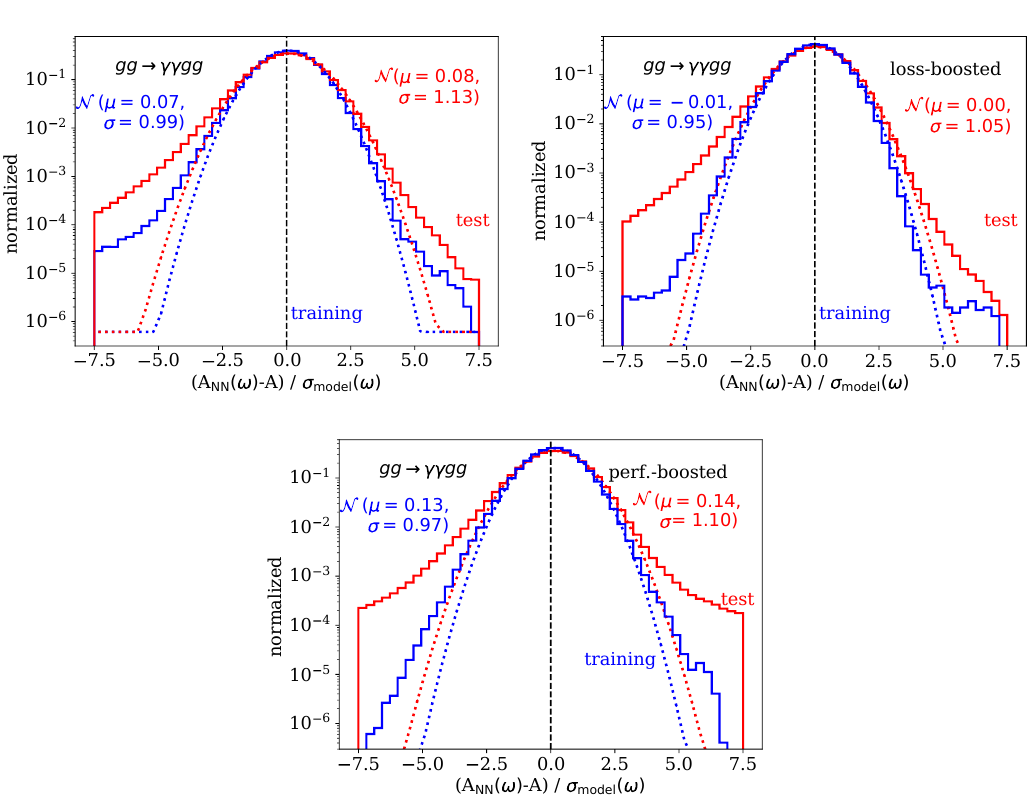
Figure 13: Pulls of the loss-bossted (left), and performance-boosted (right) BNN for the ( 2 → 4 ) -process, defined in Eq.(17) and evaluated on the training and test